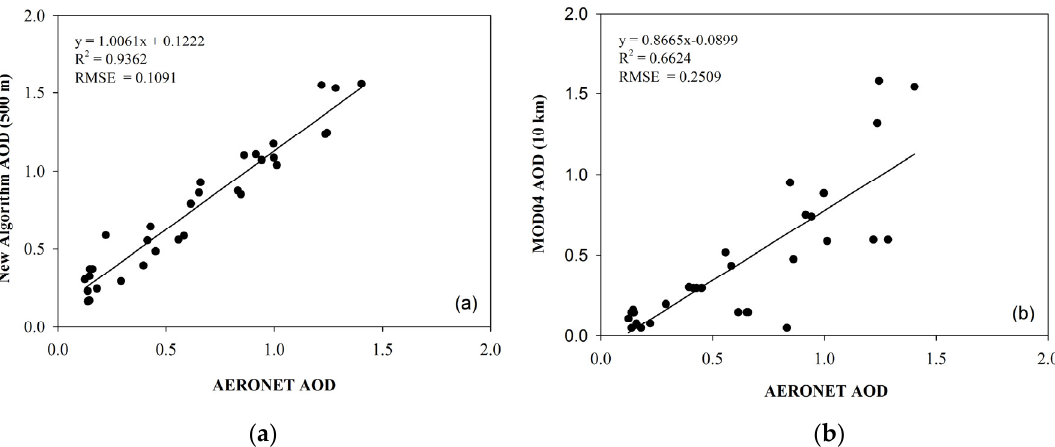
Figure 8. Comparison between AOD retrieved from Landsat 8 OLI images, the MODIS AOD product (MOD04) and the AERONET AOD measurements. The left plot is used to validate the new algorithm, and the right is used for the MOD04 product: ( a ) New algorithm and ( b ) MOD04 product.